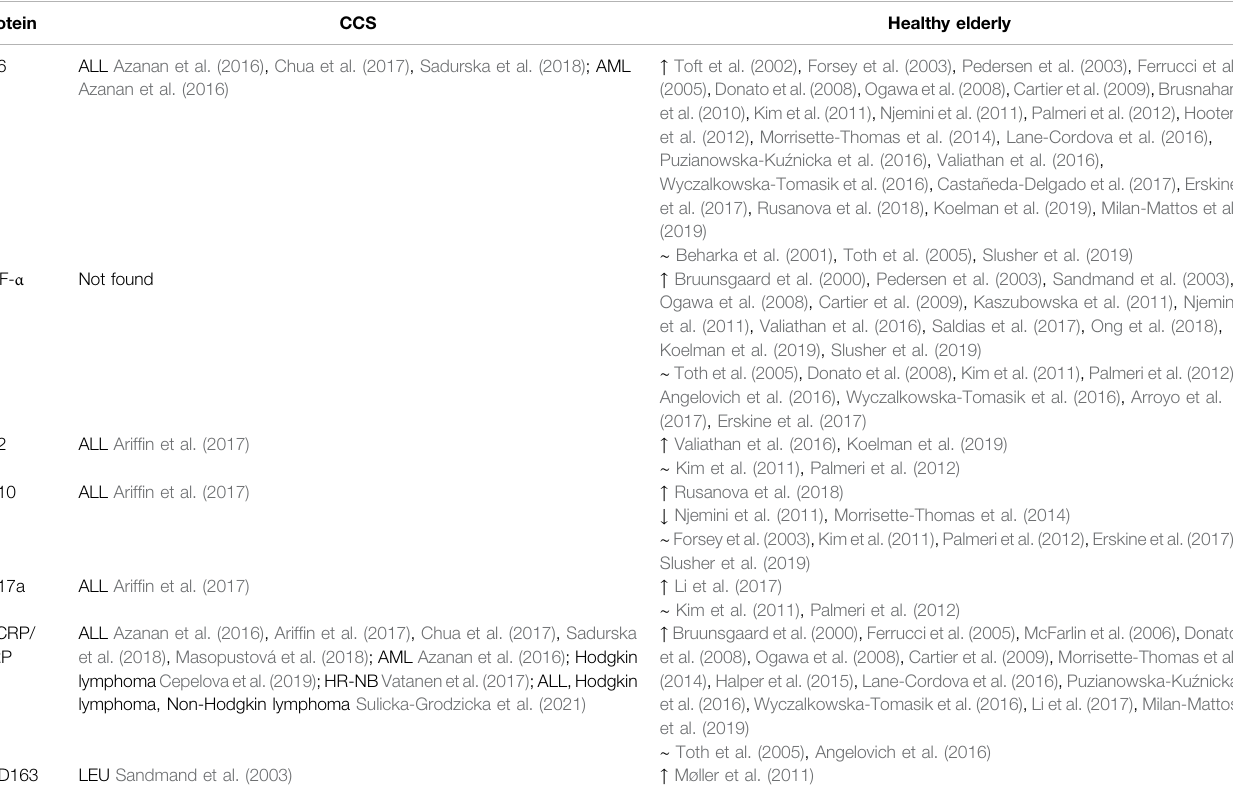
TABLE 3 | Immune mediators associated with the senescent/immunosenescent phenotype in cohorts of CCS and the healthy elderly detected in serum/plasma.